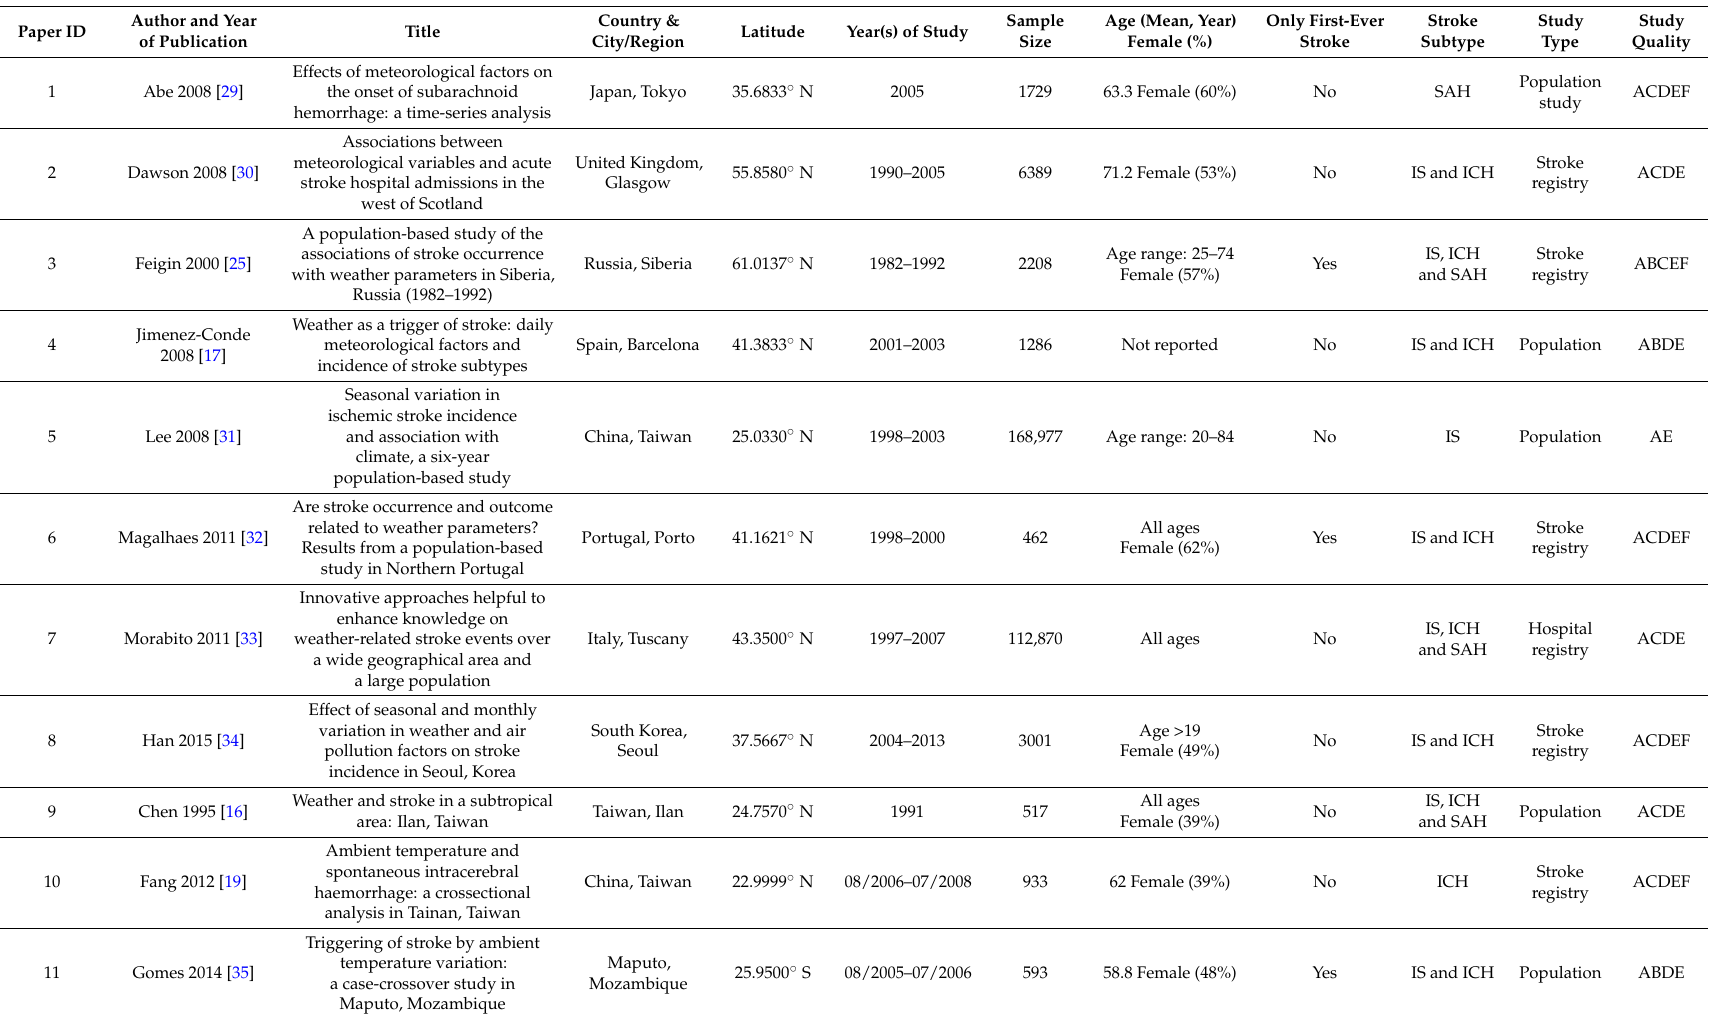
Table 1. Characteristics of studies included in the